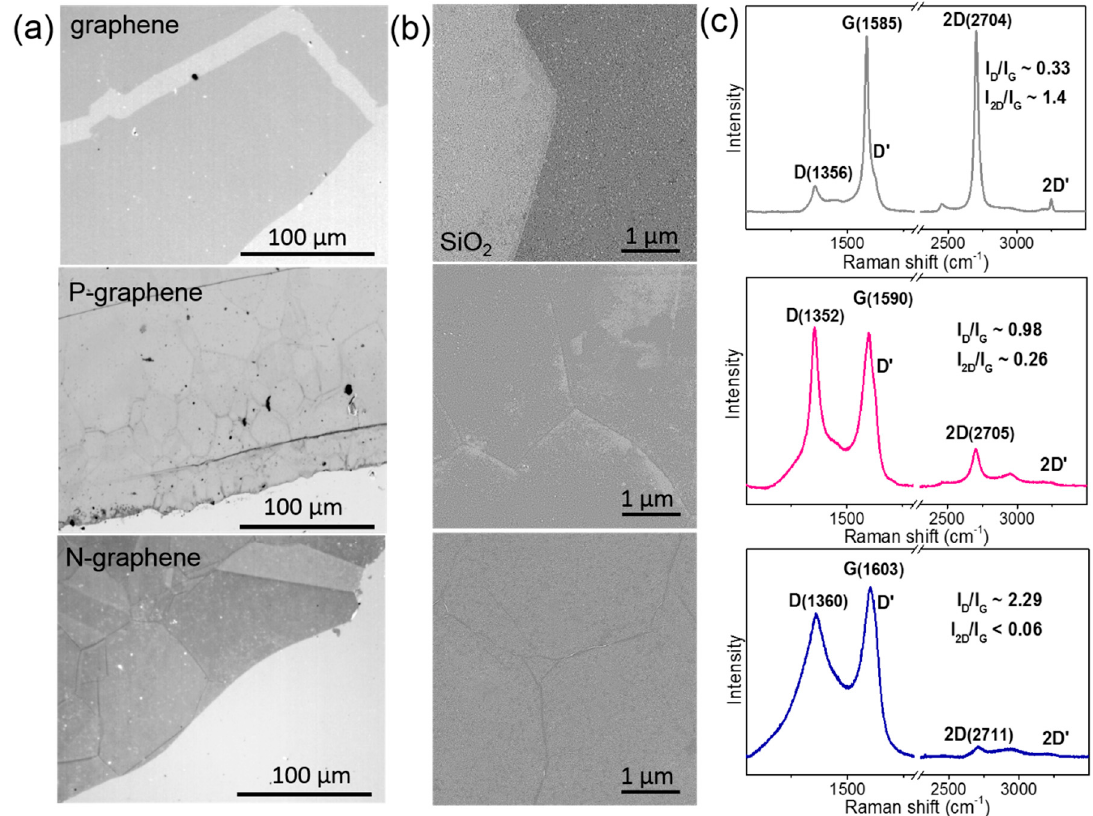
Figure 1. Structural characterization of graphene film (top), P-graphene film (center) and N-graphene film (bottom) located on SiO 2 / Si substrates: ( a ) Optical images; ( b ) SEM images; ( c ) Raman spectra measured at 514 nm.